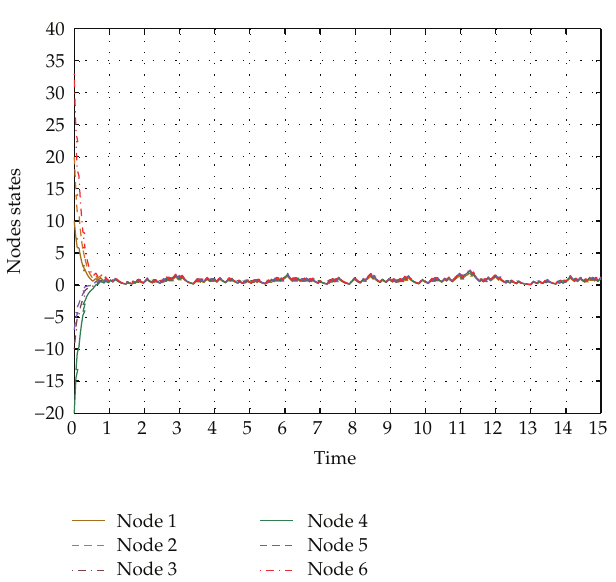
(cid:3) 1 (cid:4) (cid:9) 0, u ∗ (cid:3) 2 (cid:4) (cid:9) i i